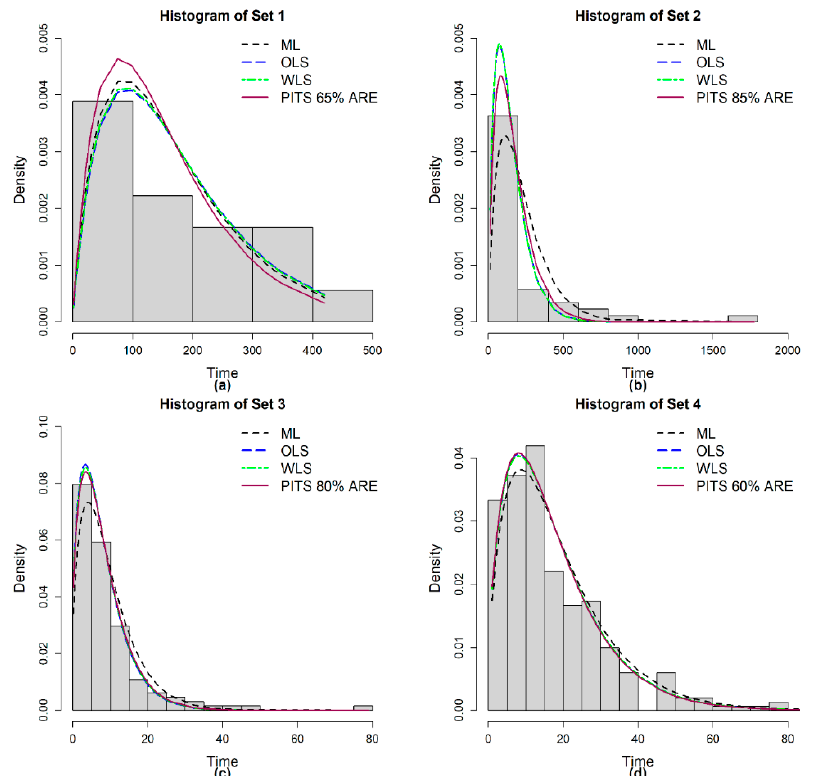
Figure 3. Fitted Lindley densities on histograms for data ( a ) Set 1, ( b ) Set 2, ( c ) Set 3 and ( d ) Set 4 by several different estimators.